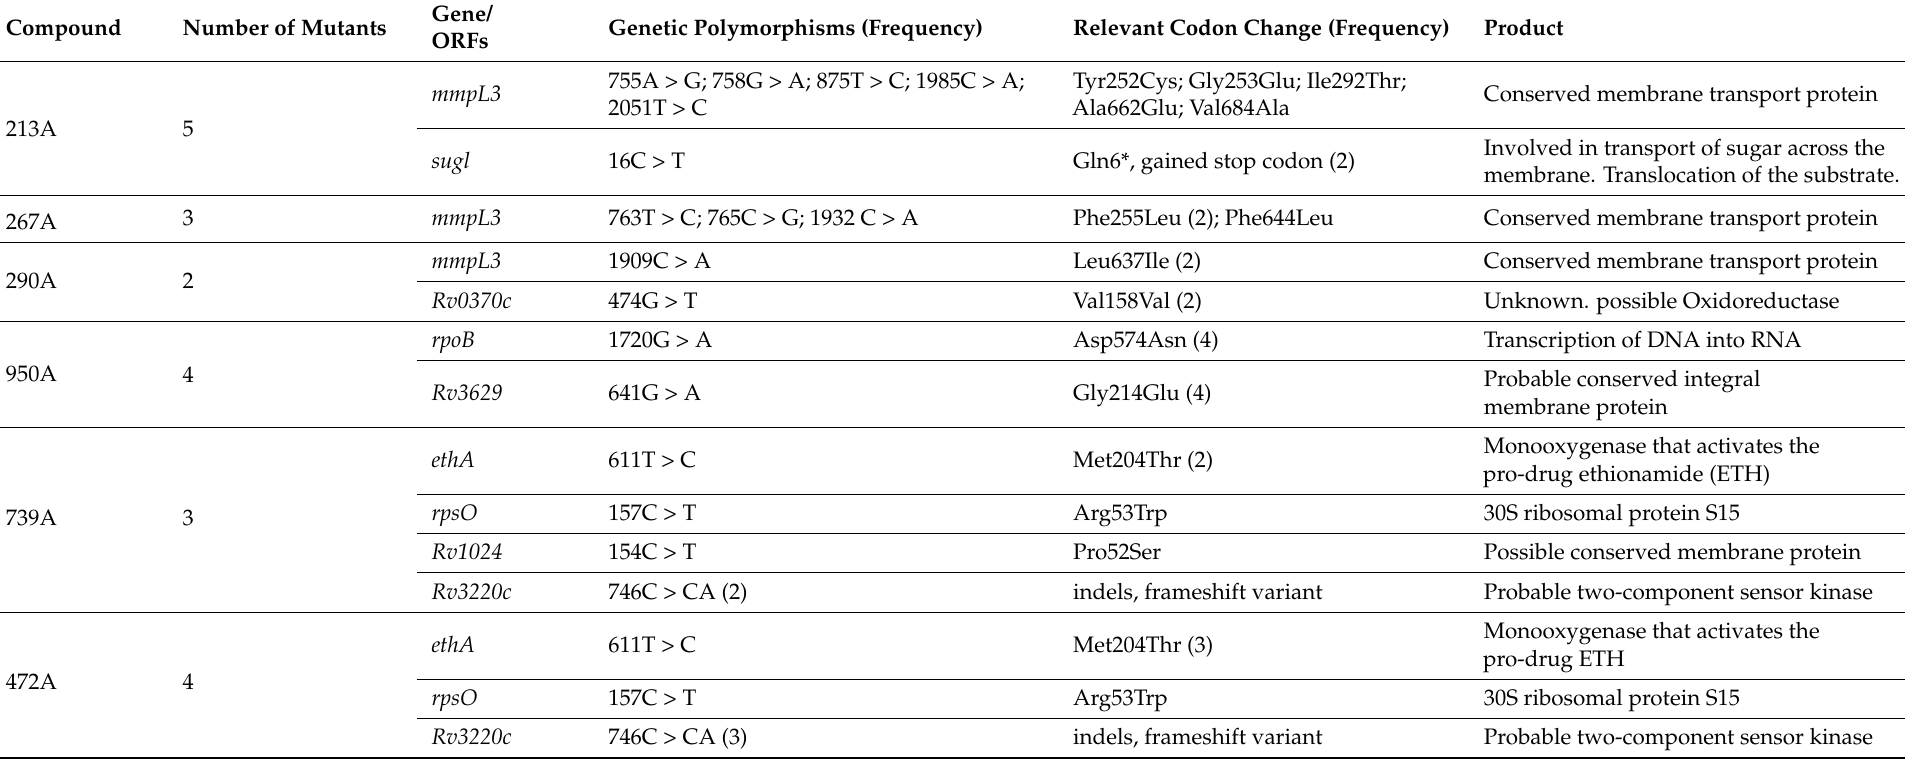
Table 2. List of SNPs and indels in various genes recovered from various mutants after whole genome sequencing (WGS). Gene names and features were displayed according to Mycobrowser annotations (https://mycobrowser.epfl.ch/, accessed on 25 August